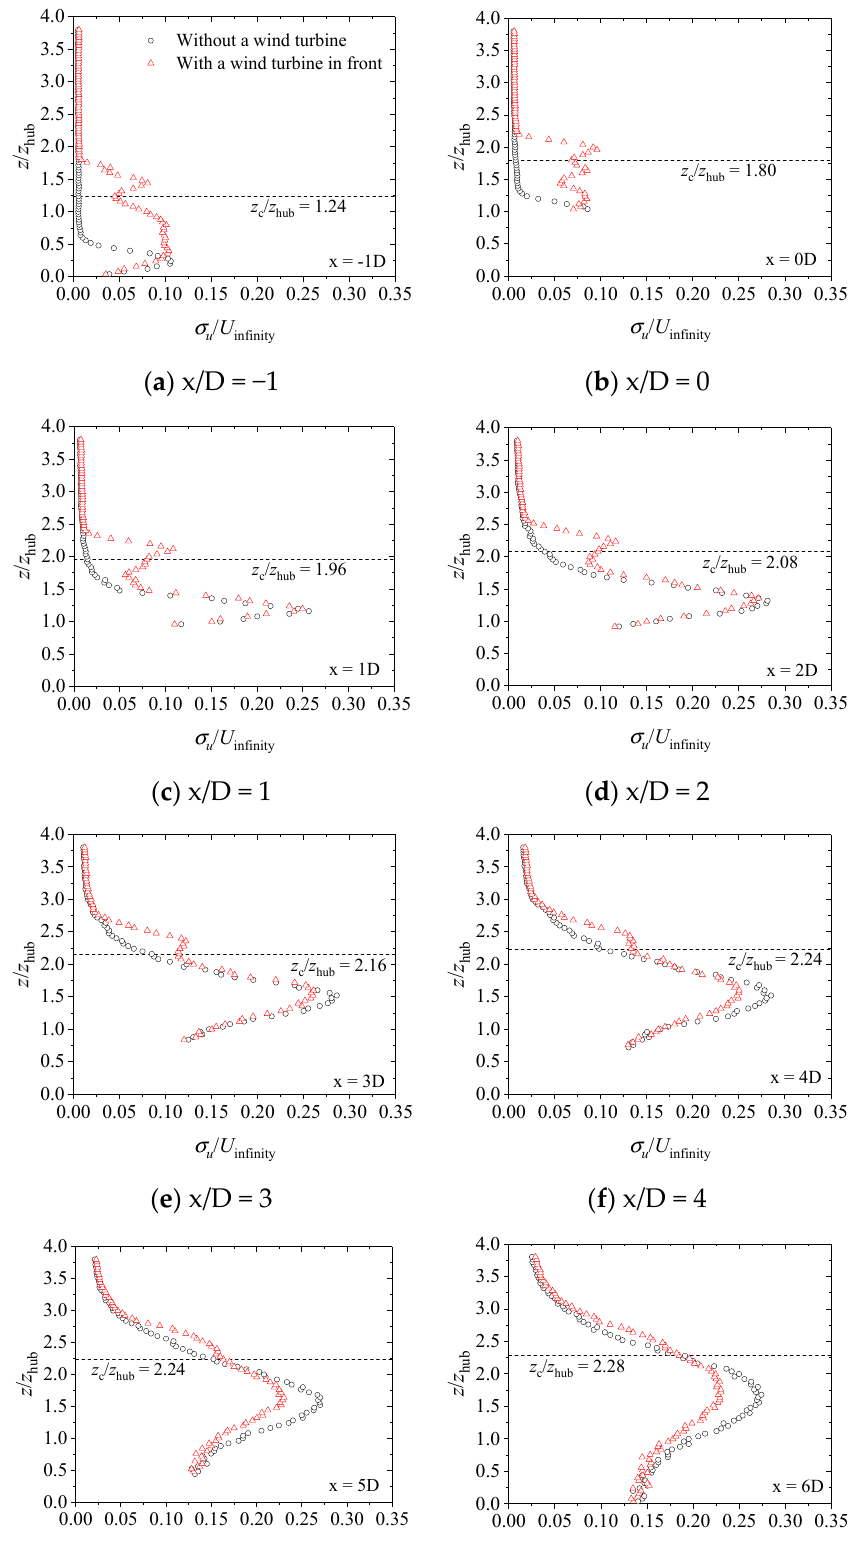
Figure 15. Vertical distribution of the turbulence intensity with and without a wind turbine located 2D in front of the hill (case 3, x/D = − 1 to 6).